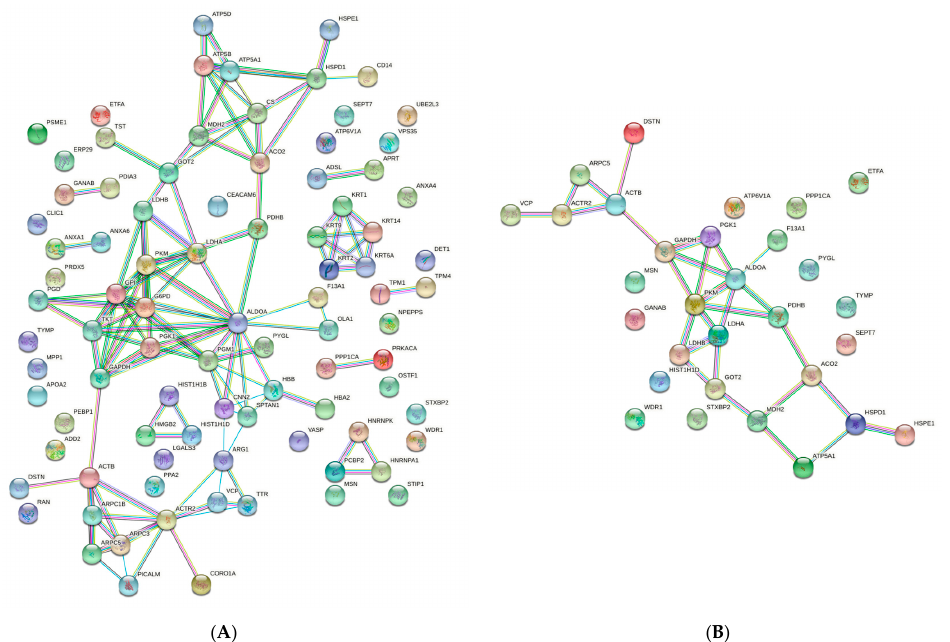
Figure 4. String network analysis. ( A ) Proteins downregulated in untreated MPS IVA patients. ( B ) Proteins ( n = 32) that remain dysregulated or partially dysregulated in ERT-treated MPS IVA patients. Abbreviations: MPS IVA, Mucopolysaccharidosis type IVA; ERT, enzyme replacement therapy.